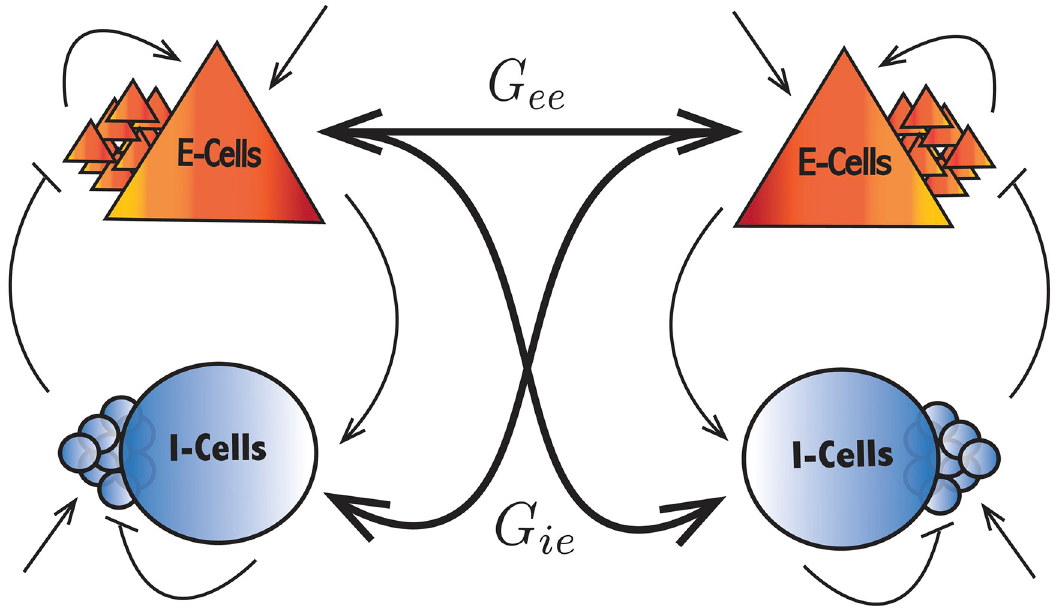
Fig 4. The bidirectionally neural circuits. The connectivity strength of the population β of one network onto the population α of the other circuit is denoted G αβ . The intrinsic parameters are unchanged and similar within each network as presented in Fig 1.